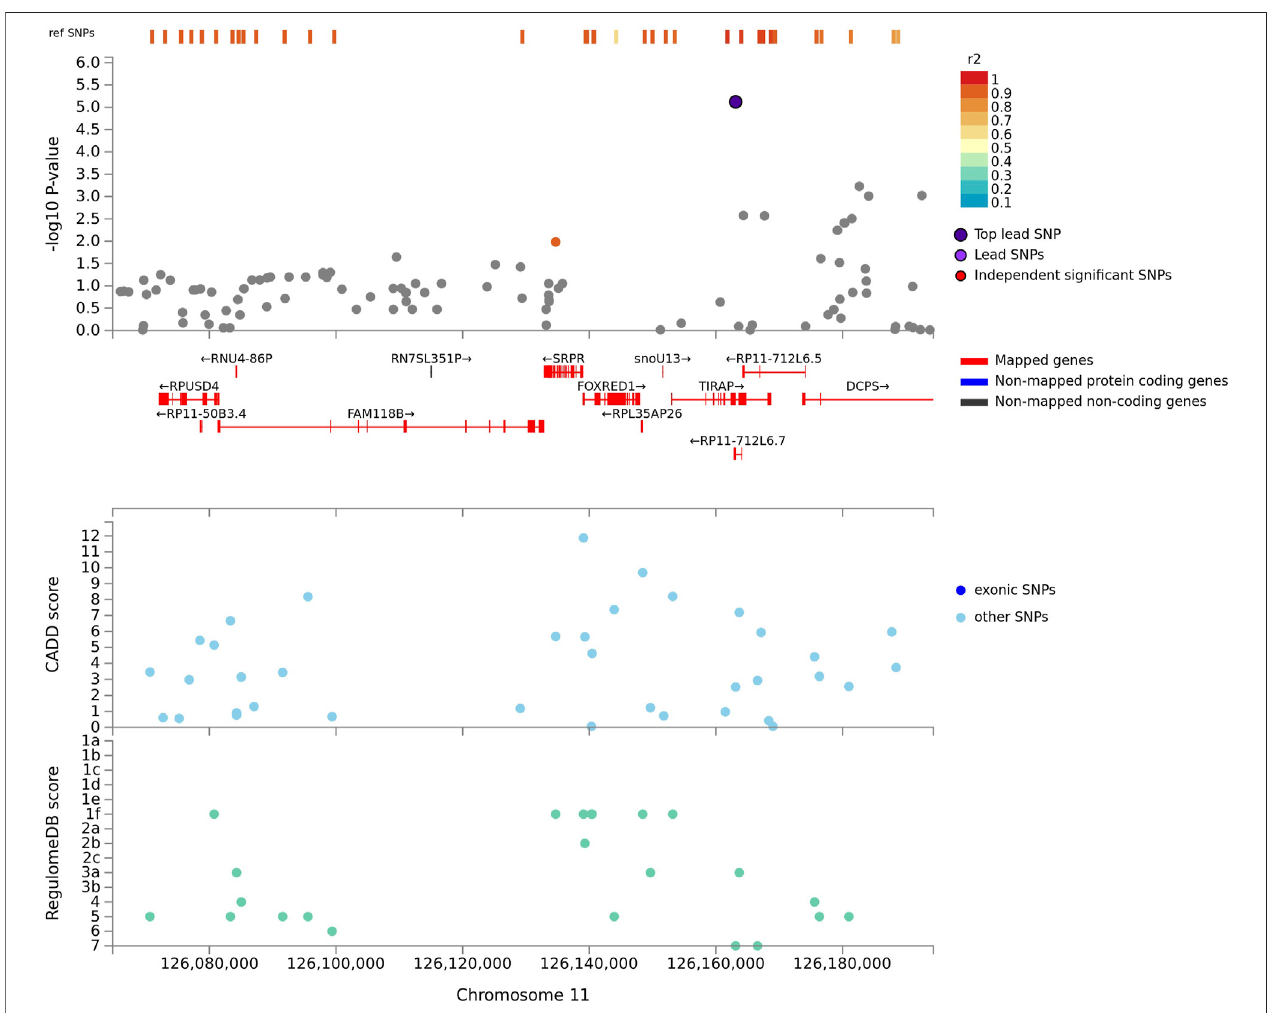
FIGURE 4 | Regional plot indicating the nearest genes in linkage disequilibrium for the lead variant observed for Bantu-speaking African ancestry on chromosome 11, whilst utilising the LAAA model. SNPs not in linkage disequilibrium are coloured grey and the lead variant is indicated in purple. Mapped genes are coded in red.